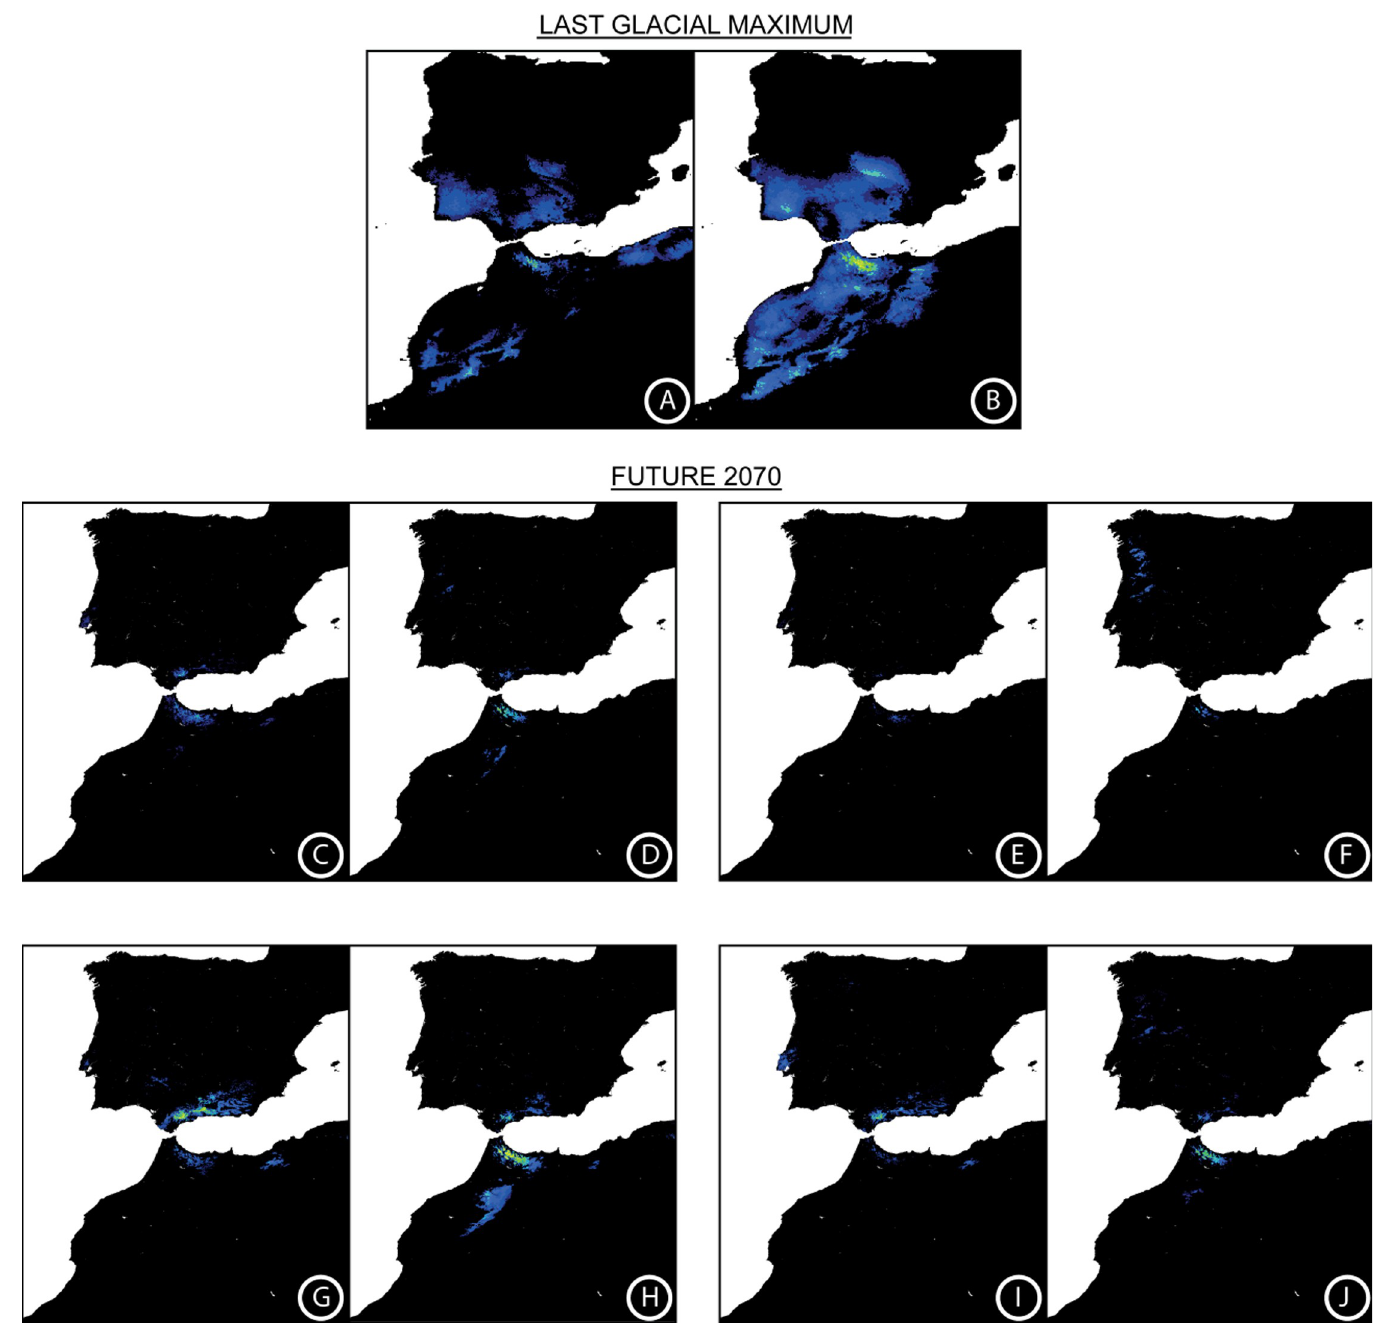
Fig 6. MaxEnt distribution map showing the environmental suitability (A–J) for Cynara baetica at the Last Glacial Maximum (LGM) and under different future conditions. LGM according to (A) CCSM and (B) MIROC models. Expected environmental suitability for the year 2070 under different conditions: (C) C . baetica subsp. baetica under GFDL-CM3 model with RCP 2.6; (D) C . baetica subsp. maroccana under GFDL-CM3 model with RCP 2.6; (E) C . baetica subsp. baetica under GFDL-CM3 model with RCP 8.5; (F) C . baetica subsp. maroccana under GFDL-CM3 model with RCP 8.5; (G) C . baetica subsp. baetica under MPI-ESM-LR model with RCP 2.6;